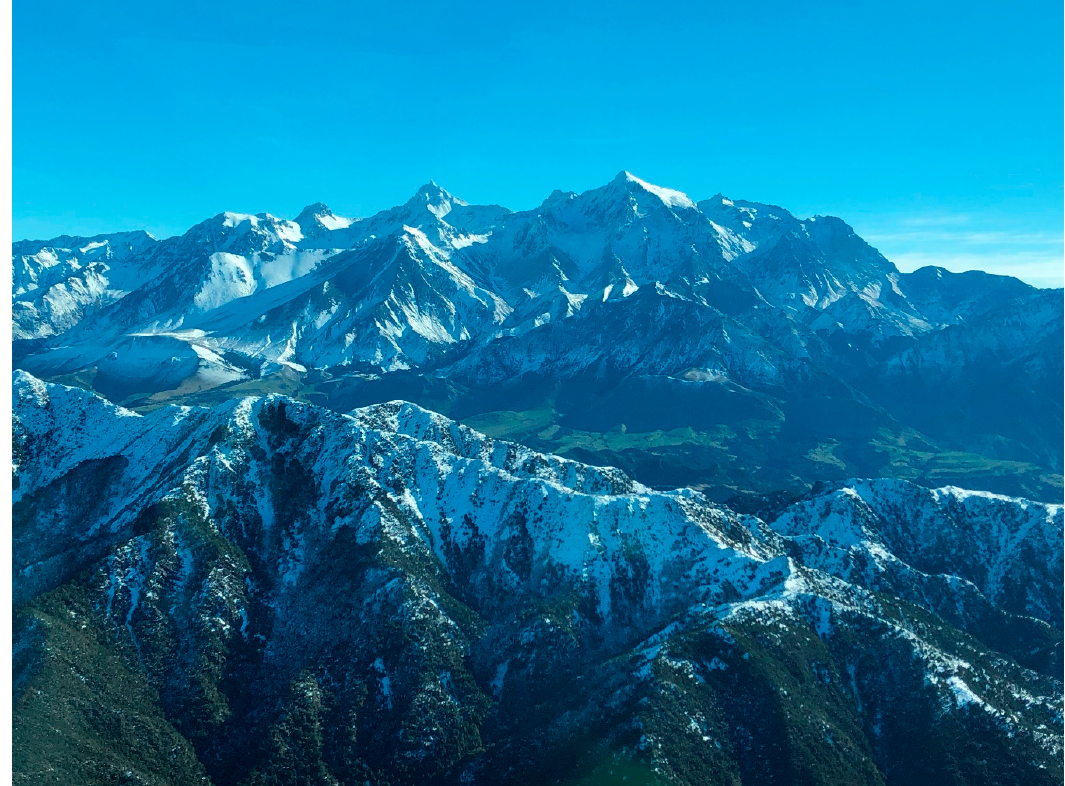
Figure 5. The steep, rugged terrain of Clarence Valley, south Marlborough, New Zealand, where red deer ( Cervus elaphus ) were net-gunned from a helicopter in 2019. The Waiautoa capture block, Seaward Kaik ō ura Range, is in the foreground, the Clarence River behind it, and the Clarence west capture block, Inland Kaik ō ura Range, is seen in the background. The type of terrain shown can play an important role in causing injury-related capture mortalities and the prescription of suitable capture methods.